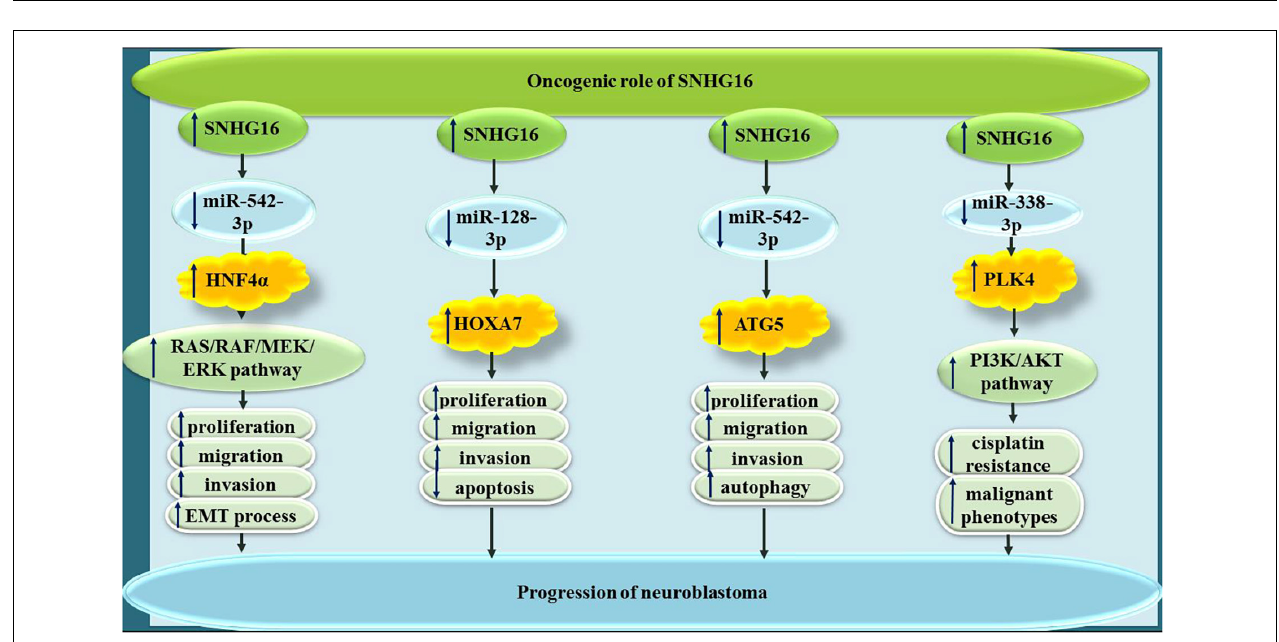
FIGURE 7 | In neuroblastoma, SNHG16 has been revealed to sponge miR-542-3p, miR-128-3p, and miR-338-3p.